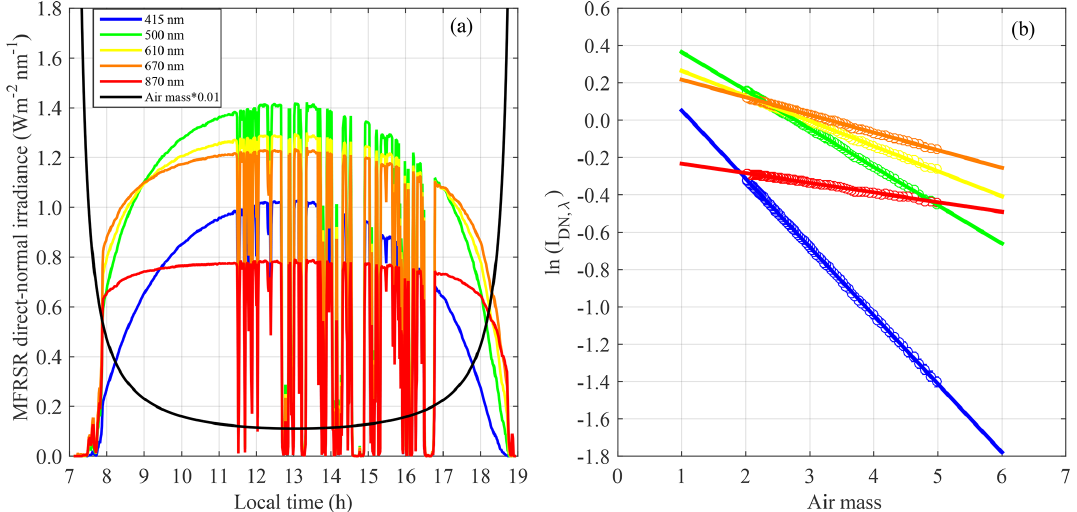
Figure 2. (a) Diurnal cycle of air mass and direct normal spectral solar irradiance measured by the MFRSR operating at the T0e site in central Amazonia. (b) Example of the Langley plot calibration applied to MFRSR spectral irradiance measurements taken during the clear sky period (08:00 to 11:00local time) of the diurnal cycle shown in (a) (day of measurements: 20 June 2012). Table 1. Individual extraterrestrial calibration results ( I o , 500nm ) applying the Langley plot technique to measurements of solar direct normal irradiance at 500nm from a MFRSR operating at the T0e site in central Amazonia for 2012. The individual uncertainty ( σ I to obtain the relative error ( σ I (%)) was estimated from the intercept and its respective uncertainty ( σ intercept ) derived from the least- o , 500nm square regression